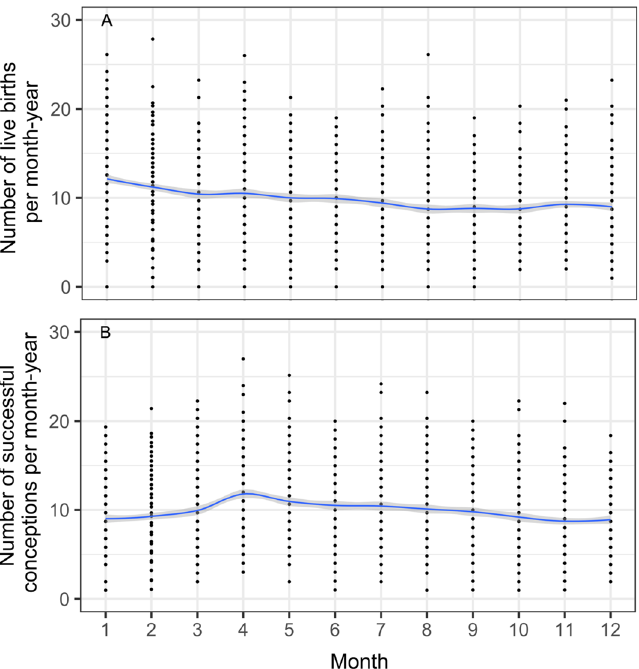
Figure 2. Average seasonalities of (A) births and (B) conceptions over the time period 1782-2004. Fitted lines show gamms and grey areas their 95% confidence intervals. These average seasonalities are statistically significant, as shown in Fig. S2A,B. Changes in birth seasonality after the 1950’s are shown in Fig. S3 and Fig.